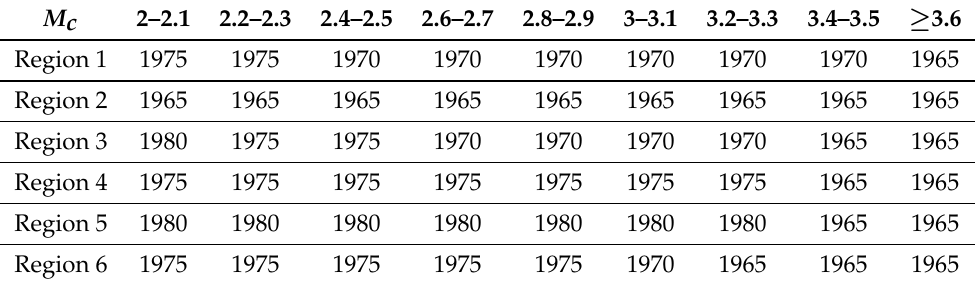
Table A2. Cut-off years obtained from instrumental catalogue in each SHARE region according to the cumulative visual method [36,37]. Region numbers refer to Figure